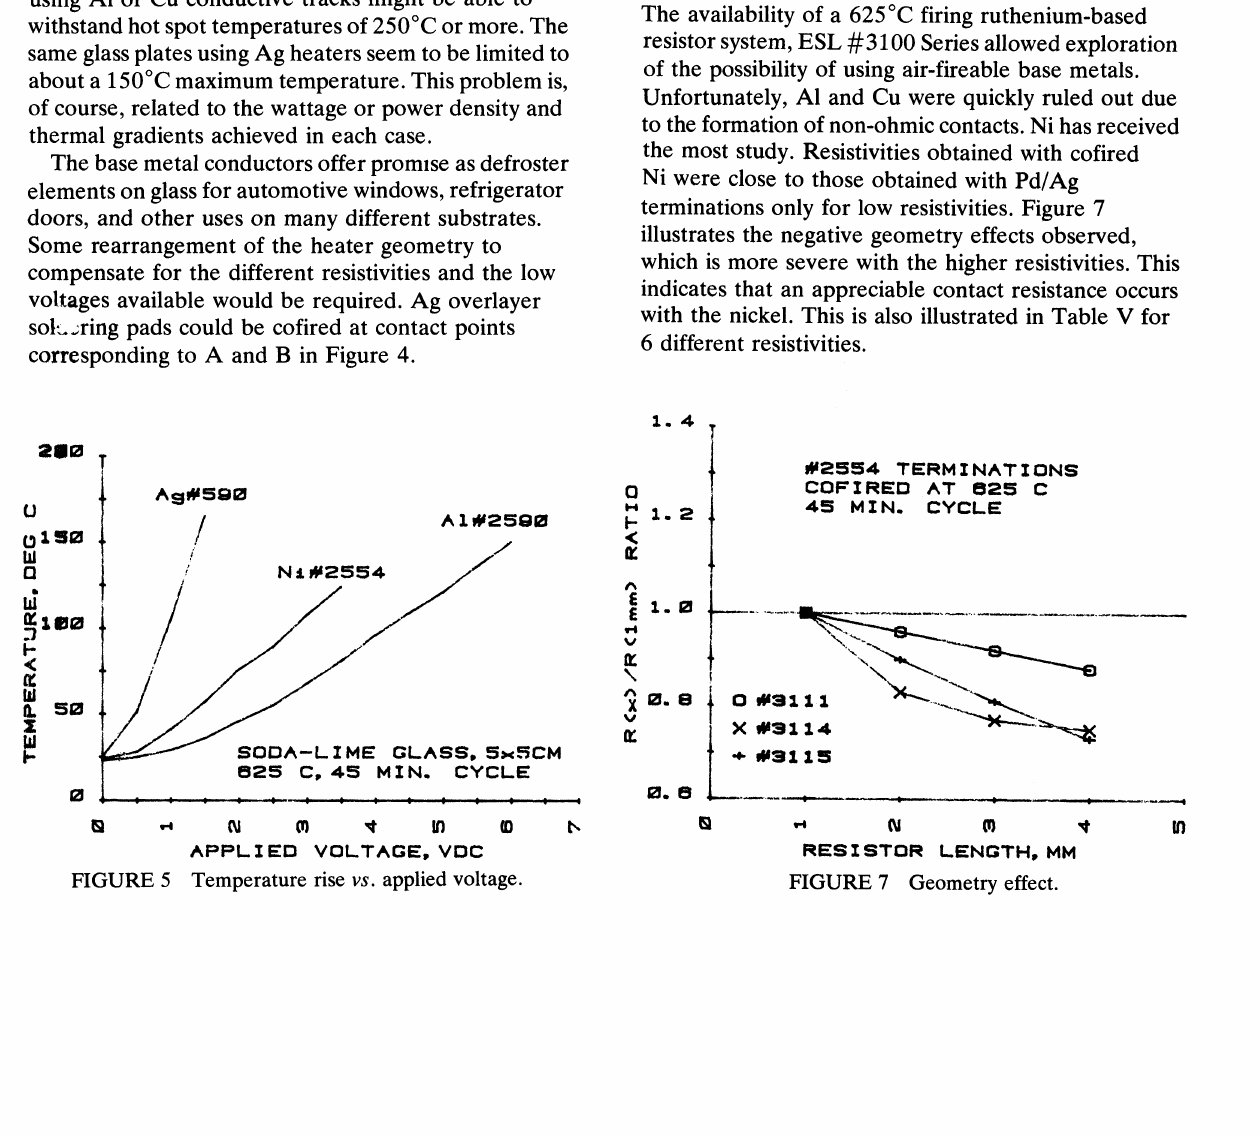
FIGURE 5 Temperature rise vs. applied